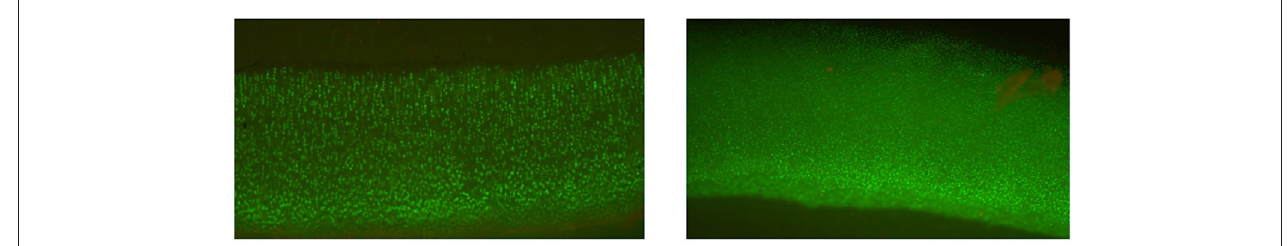
FIGURE 2 | Images of a dog with a medial femoral osteochondritis dissecans lesion treated with an osteochondral allograft (OCA). (a) Pre-operative CT 3-D reconstruction showing the defect. (b) Donor stifle, (c) Harvested OCA plug, (d) Intra-operative image showing graft implantation through a caudomedial arthrotomy, (e) Immediate post-operative radiograph, and (f) 8-week post-op-radiograph. This dog developed a seroma that resolved without treatment and then achieved a full functional outcome.